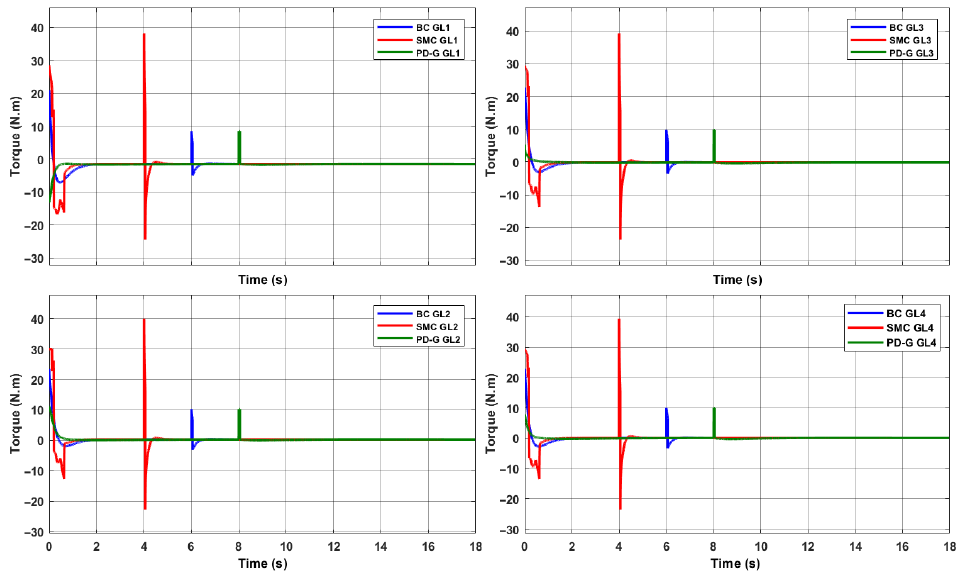
Figure 12. Torques applied with the controllers proposed to the 4DDL of the manipulator. A disturbance is observed of the same magnitude that has been applied at different times for each controller, with the SMC control being the one that requires the highest torque value to adequately regulate the requested position of each servomotor. Figure 13 shows the positions generated with this control variable applying a torque disturbance for SMC in 4 s, BC in 6 s and PD+G in 8 s.